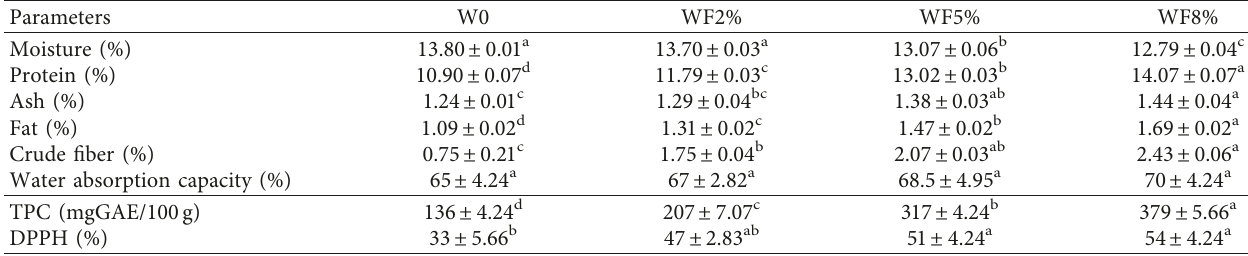
Table 1: Chemical composition (%) of wheat and wheat-fenugreek flour blends. Parameters